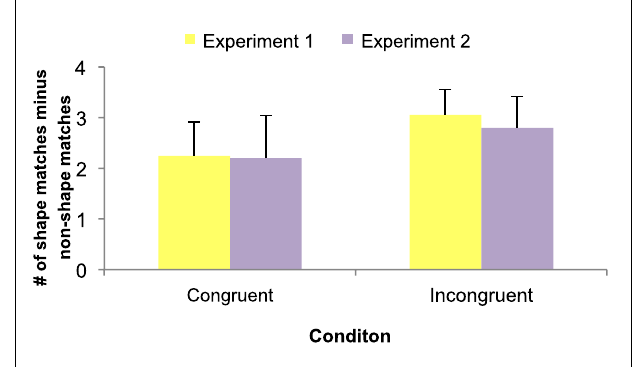
FIGURE 4 | Results of the conditions of interest in Experiments 1 and